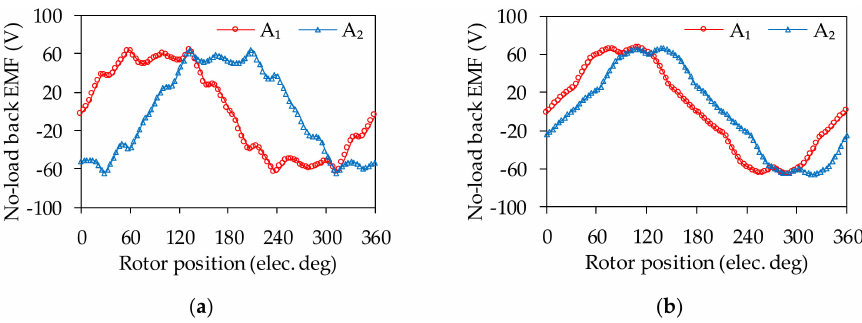
Figure 8. Machine sections: ( a ) proposed machine; ( b ) conventional machine.